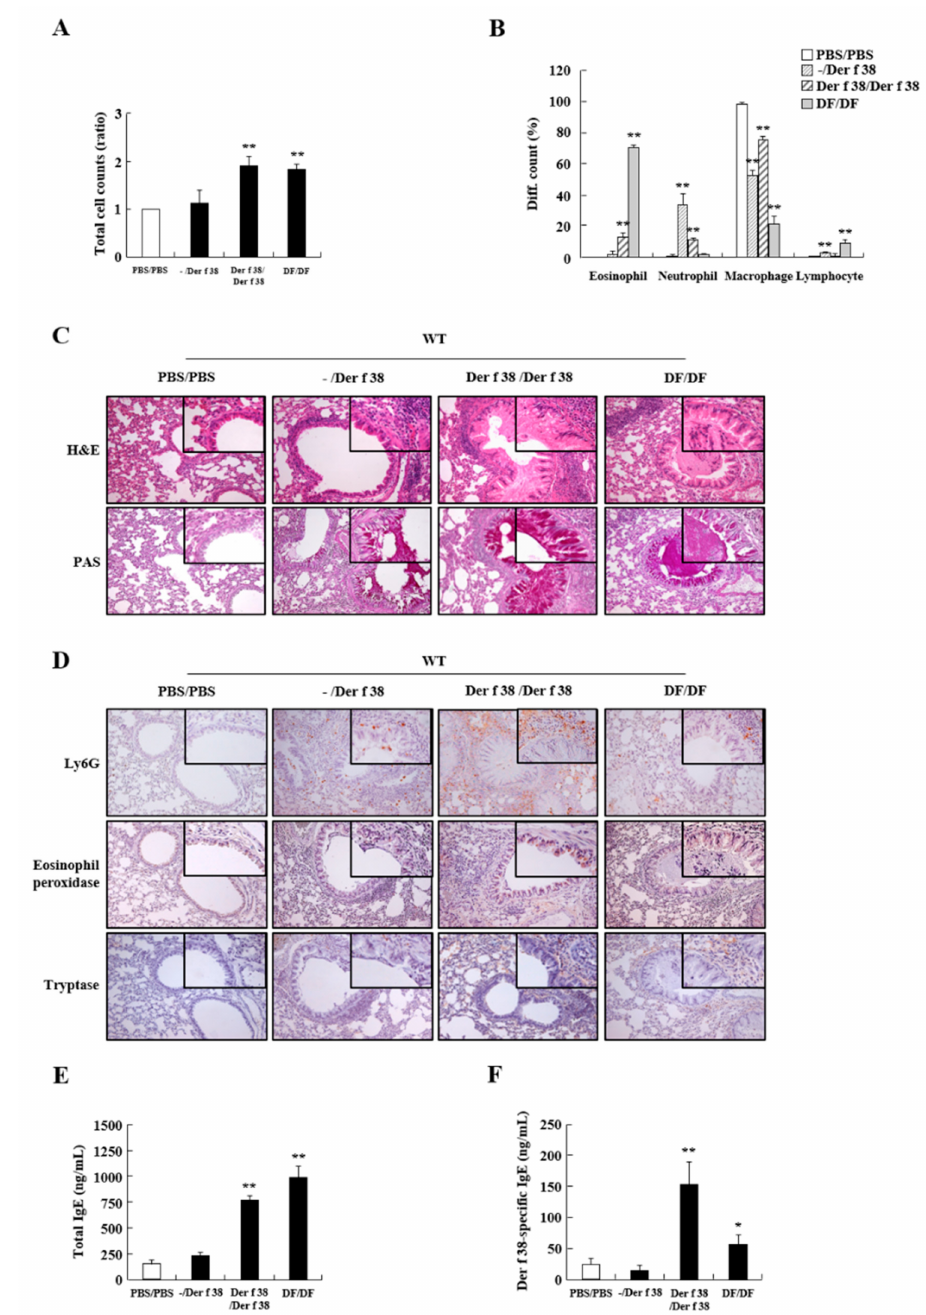
Figure 3. Der f 38 triggers infiltration of inflammatory cells into the lung and mucin hypersecretion in WT mice. ( A , B ) Total cell ( A ) and differential cell counts ( B ) in BALF of BALB/c mice after the IN or/and IP administration of PBS, Der f 38, or DF extract. ( C , D ) Lung tissues from mice were stained with hematoxylin and eosin (H&E) and periodic acid-Schiff (PAS) ( C ) or stained with antibodies against Ly6G, eosinophil peroxidase, and tryptase ( D ). ( E , F ) Total IgE ( E ) and Der f 38-specific IgE ( F ) levels in mice sera were evaluated. Data are presented as the mean ± S.D. * p < 0.05; ** p < 0.01, significant differences between control and stimulator-treated groups. Magnification, × 200 ( C , D